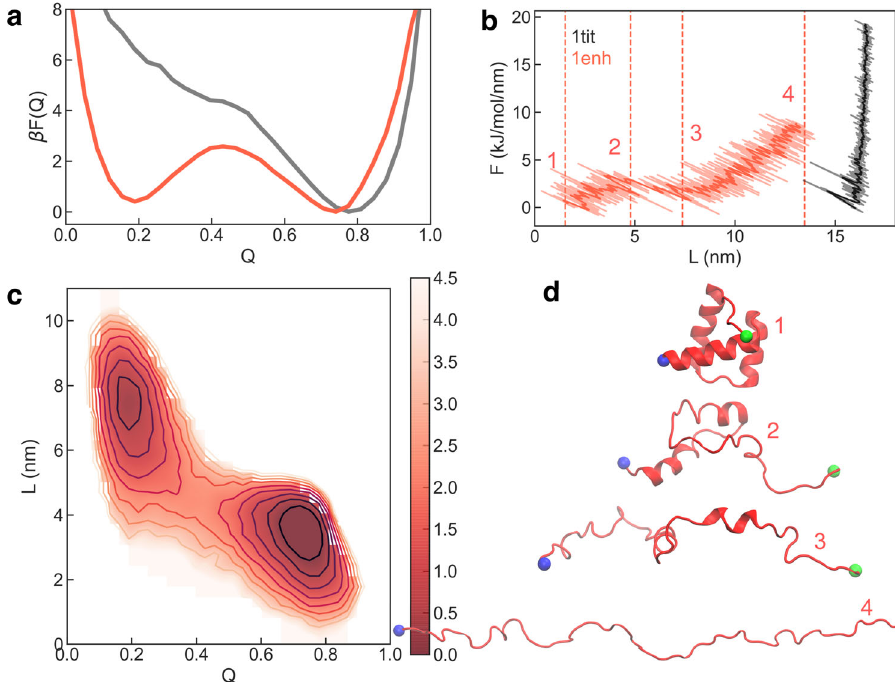
Fig. 2 Course-grained molecular dynamics simulations. a Potential of mean force for the projection of coarse-grained simulations on the fraction of native contacts, Q . The black curve corresponds to the simulations in native conditions, and the red curve at the mechanical midpoint. b Force-extension curves from simulations at a constant pulling speed of 1e − 3 nm/ps for EnHD (red) and titin (black). c Free energy landscape for both the end-to-end extension, L , and Q . Contour lines mark 0.5 k B T . d Cartoon representation of different conformations sampled during the mechanical unfolding, with timestamps relative to the numbering in. The green and blue beads correspond to the alpha carbons of the N and C-termini,